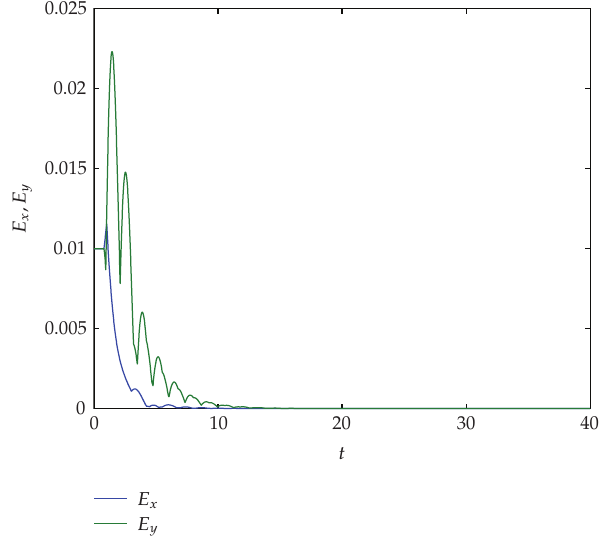
Figure 2: Inner synchronization evolution curves with τ x (cid:7) τ y (cid:7) 0 . 8.